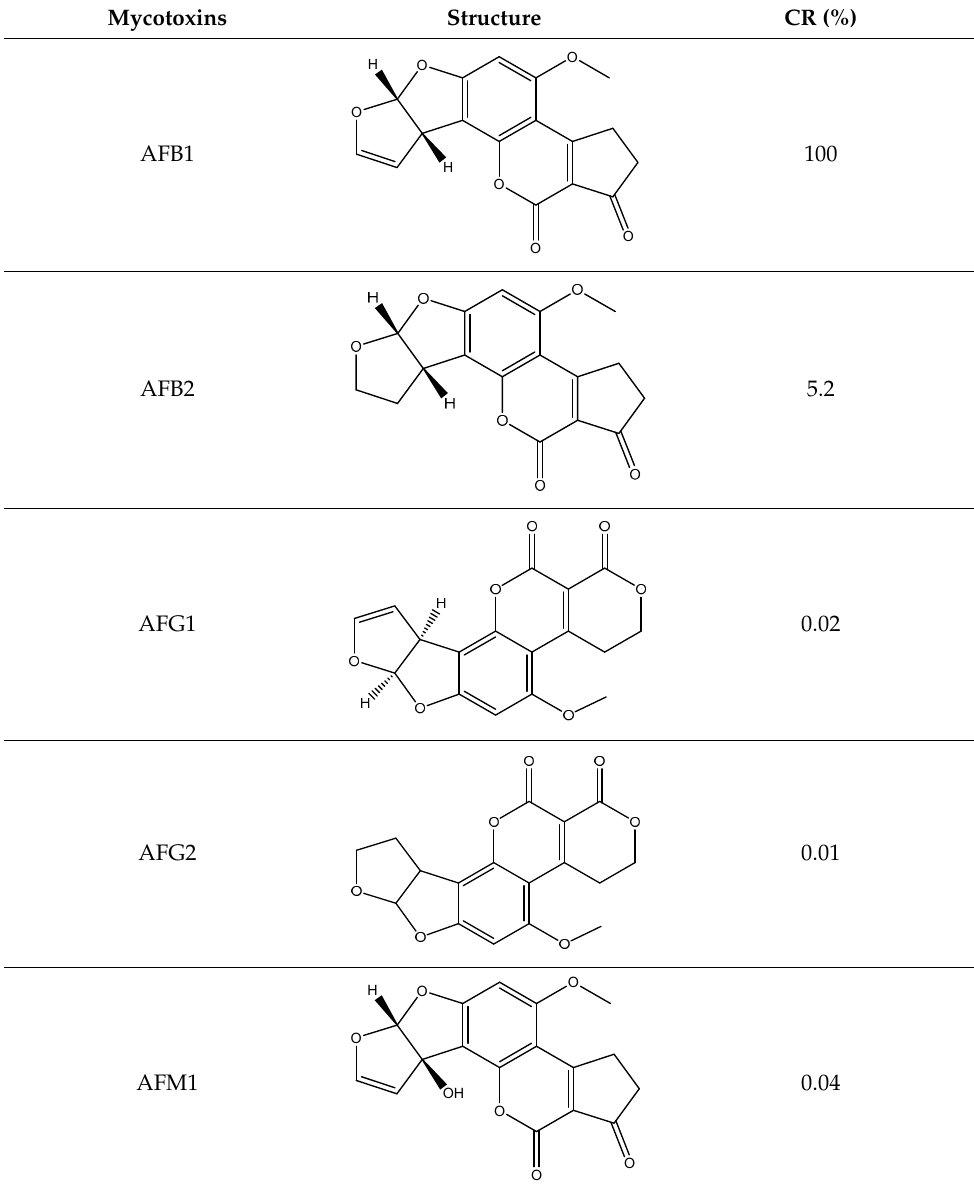
Table 1. The cross reactivity of AFB1 against other analogues (AFB2, AFG1, AFG2, AFM1).